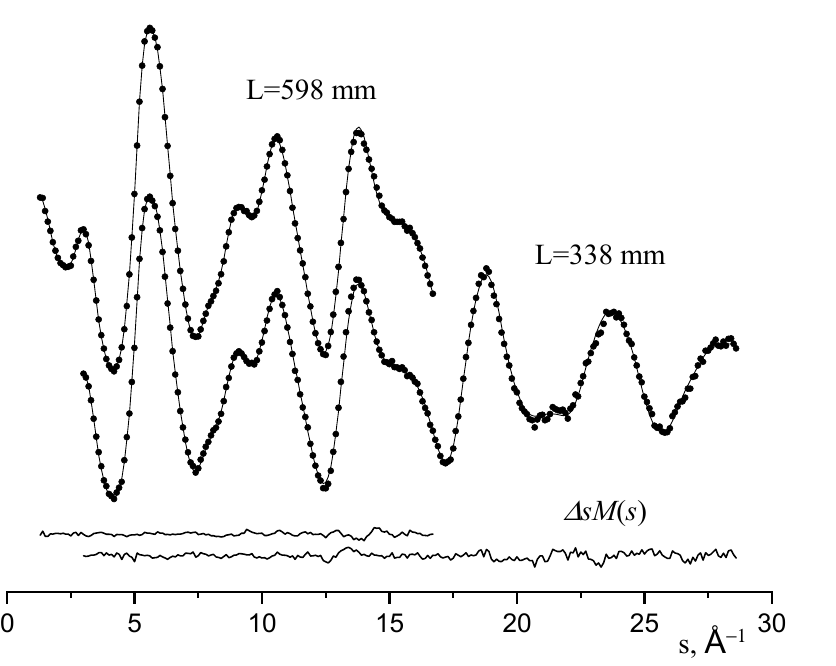
Figure 9. Experimental (dots) and theoretical (full line) molecular intensities sM(s) for mole percent of 50/50 cis/trans vapor model and residual curves for 4-(4-tritylphenoxy)phthalonitrile.